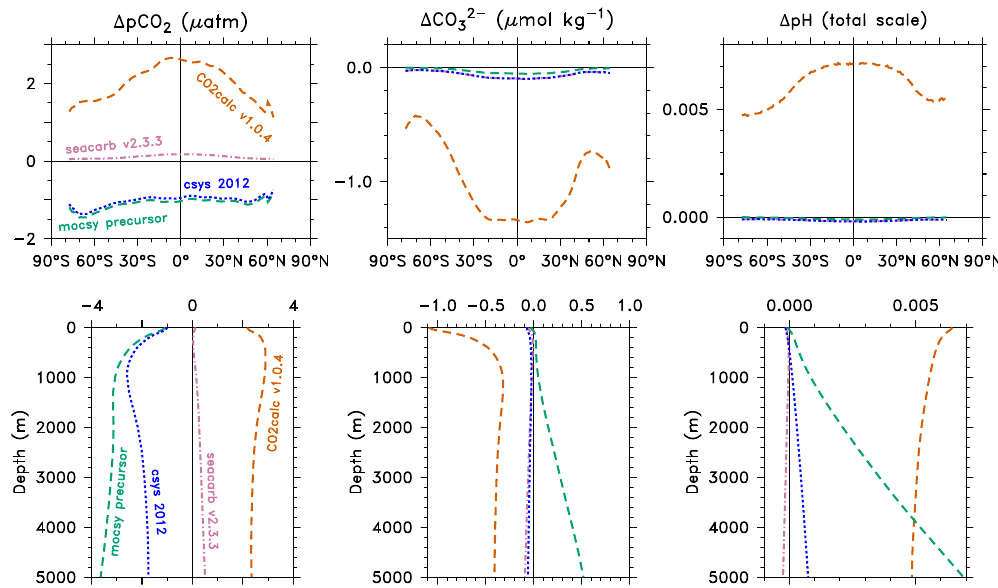
Figure 4. Global zonal-mean surface values (top) and global-mean vertical profiles (bottom) from outdated versions of packages for p CO 2 (left), CO 2 − (middle), and pH (right) as computed from GLODAP A T and C T as in Figs. 3 and 2. The four older versions include CO2calc 3 (v1.0.4), csys (from 3 February 2010), seacarb (v2.3.3), and mocsy (non public predecessor from Orr et al., 2005). As before, results are shown after subtracting off corresponding results from the same CO2SYS-MATLAB